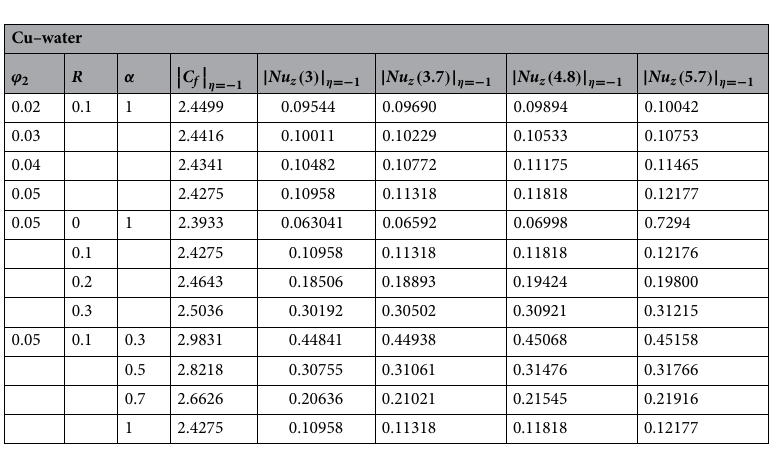
Table 3. Numerical variation in shear stress at the lower porous wall with different shape factors for ϕ 2 , ϕ 1 = 0, R , α ( Cu − water) ( N fd ).